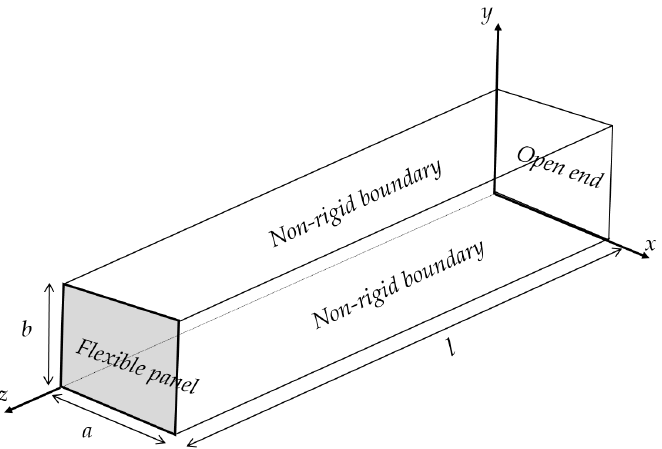
Figure 3. Schematic diagram of a rectangular tube with a flexible end and non ‐ rigid acoustic boundaries.